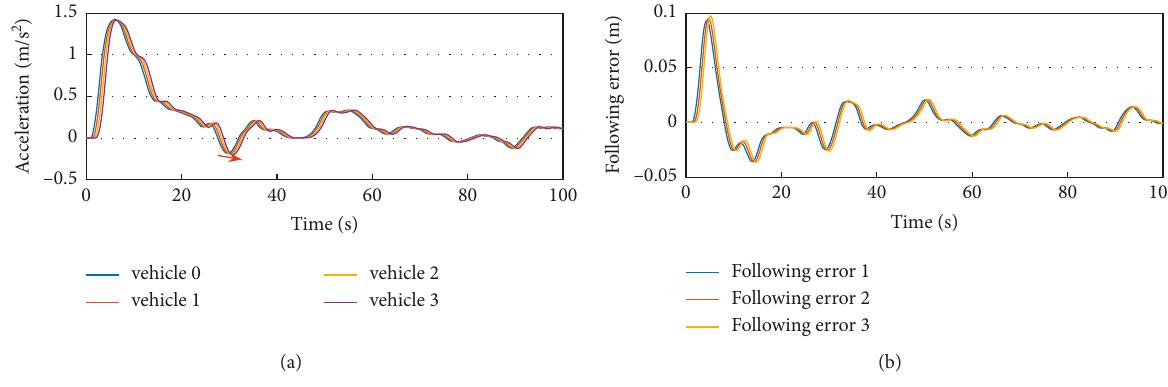
Figure 14: The simulation results of traditional architecture.